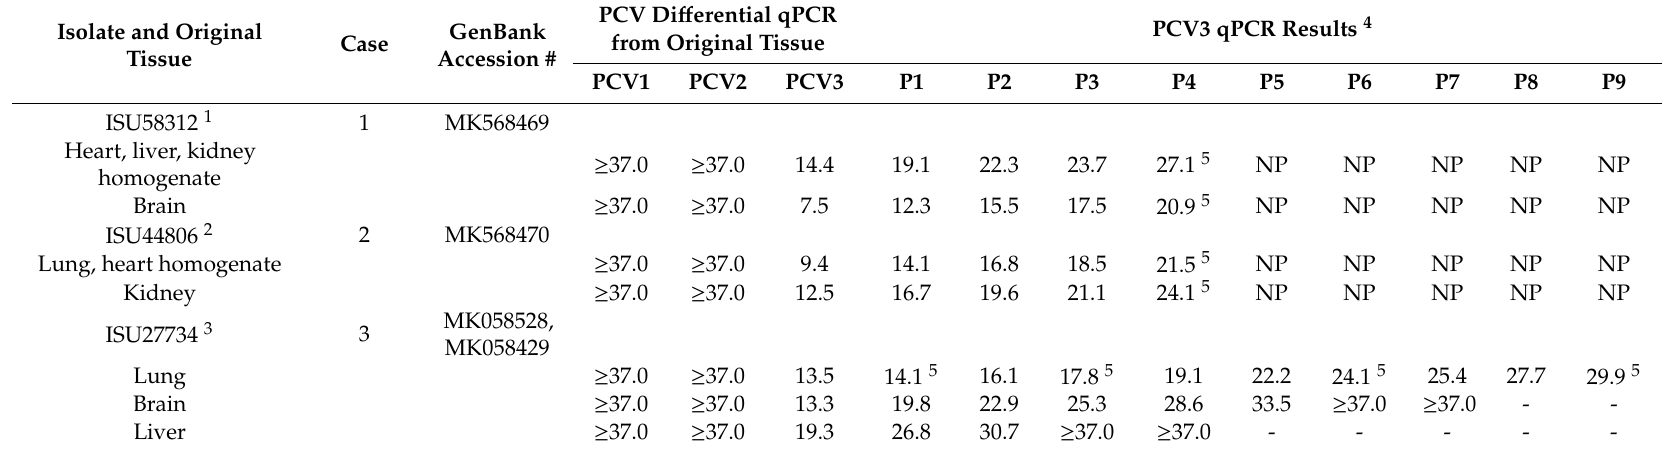
Table 1. Summary of PCV3 isolation from clinical cases and qPCR values (quantitation cycle or Cq values) during passages in cell culture. Isolate and